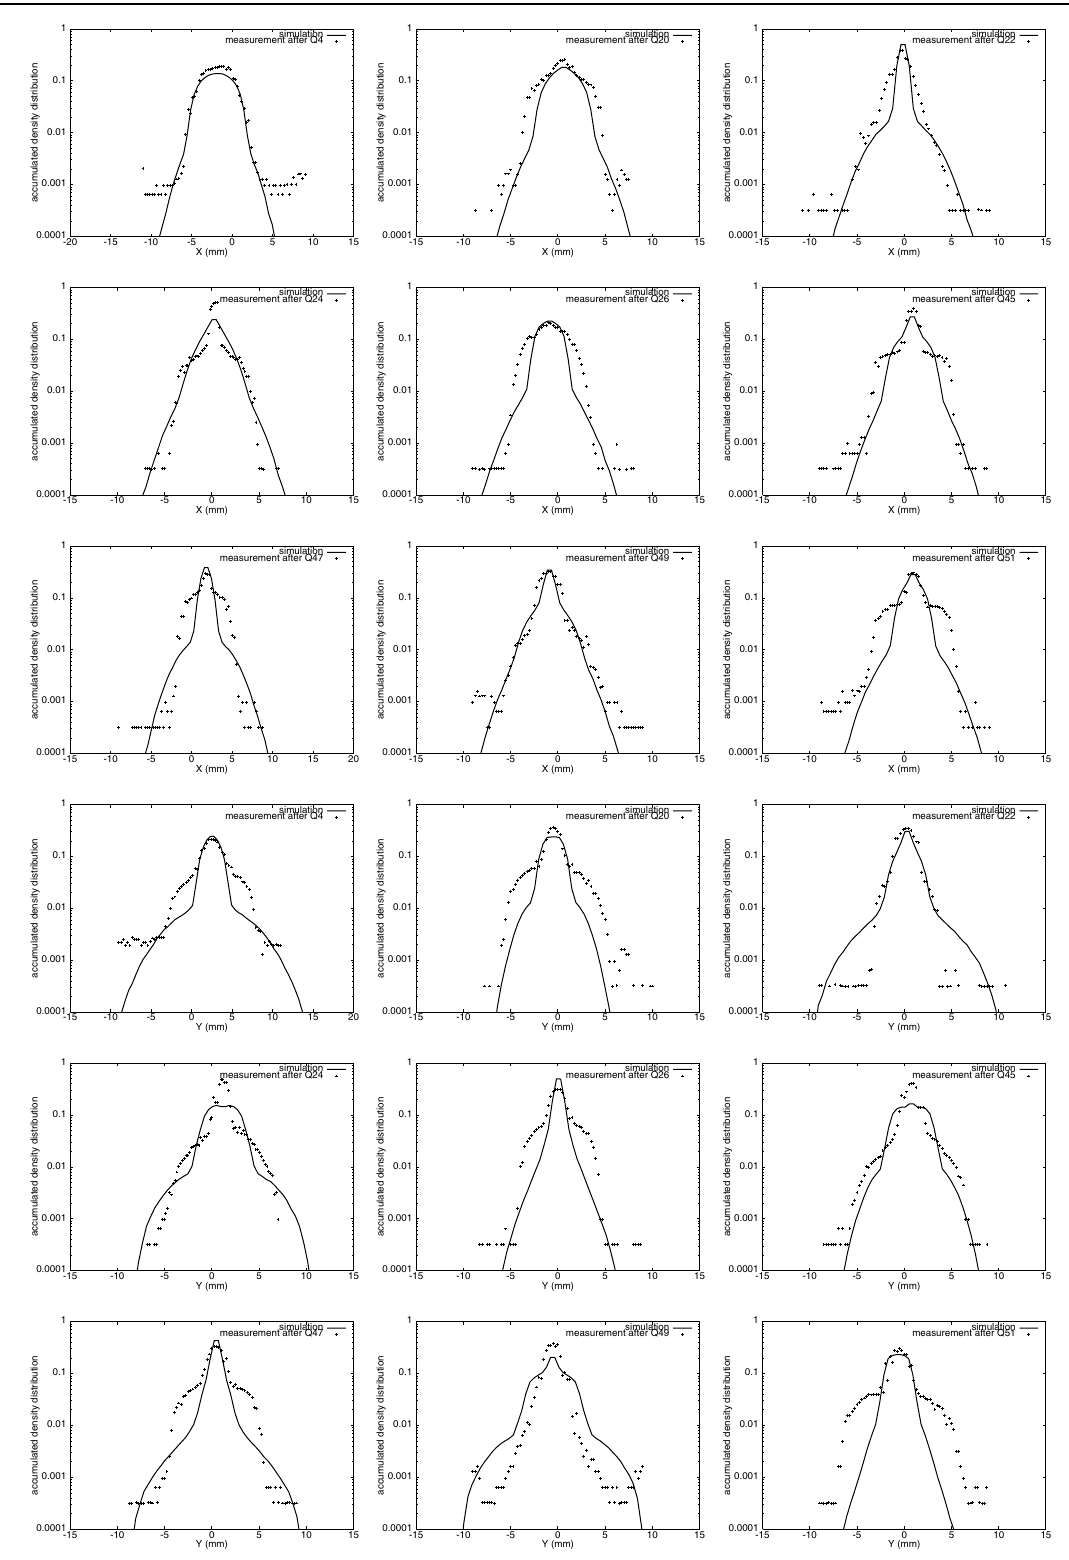
FIG. 13. X and y density distribution from simulation using initial double-Gaussian distribution and from measurements at 75 mA and mismatch factor of 1.5. The first nine plots correspond to the nine x profiles and the second nine plots correspond to the nine y